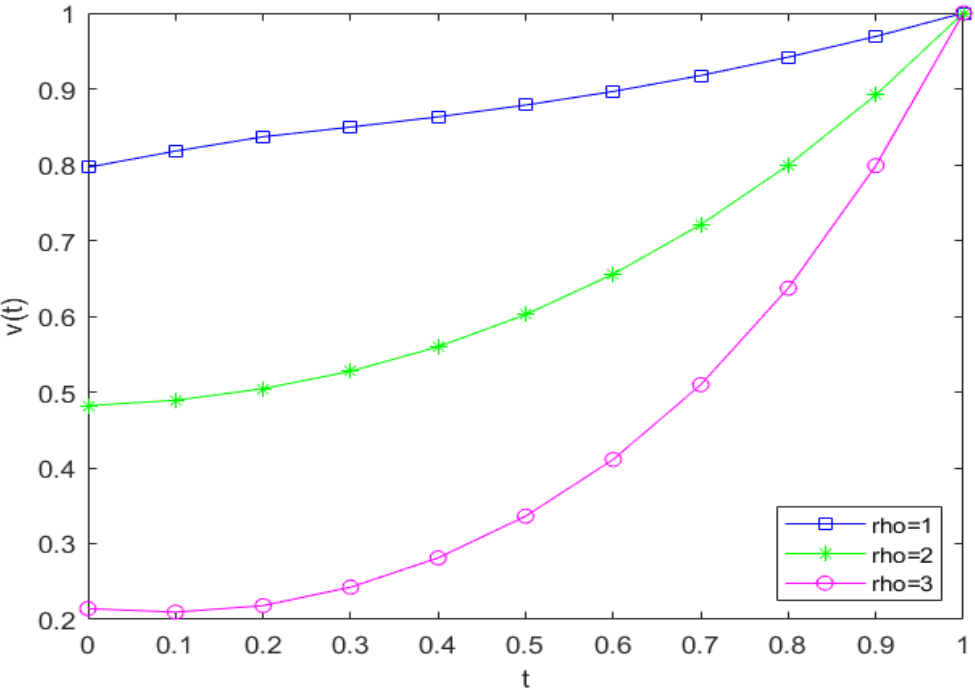
Figure 3. Effect of the Thiele modulus for different values of the parameter ρ on the concentration v ( t ; µ , ρ ) .